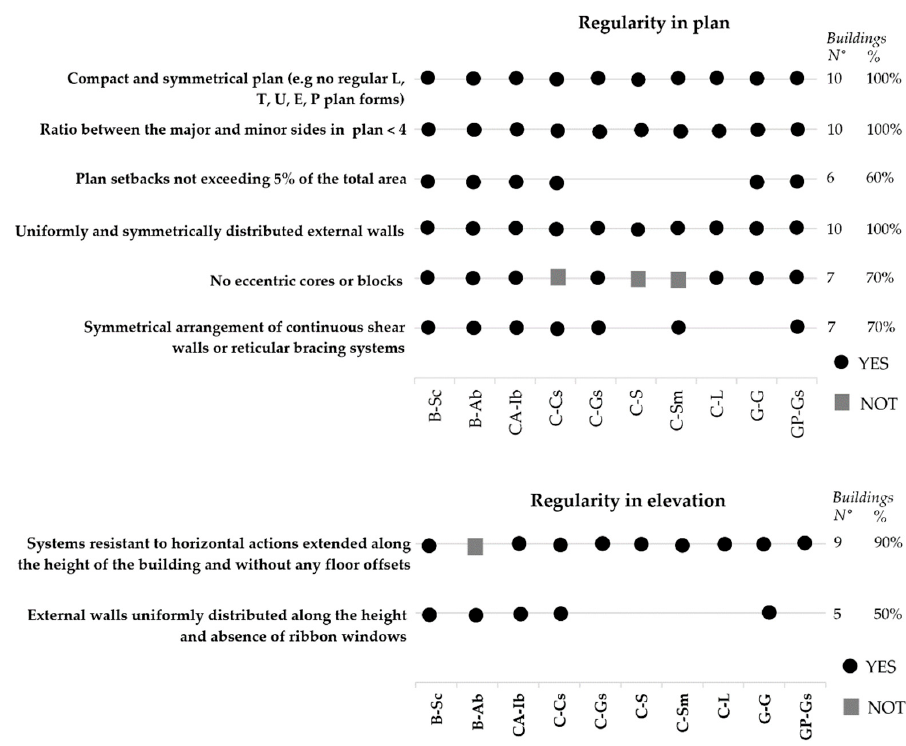
Figure 26. Section 3 CARTIS-Building. Other information: Regularity in plan and in elevation.